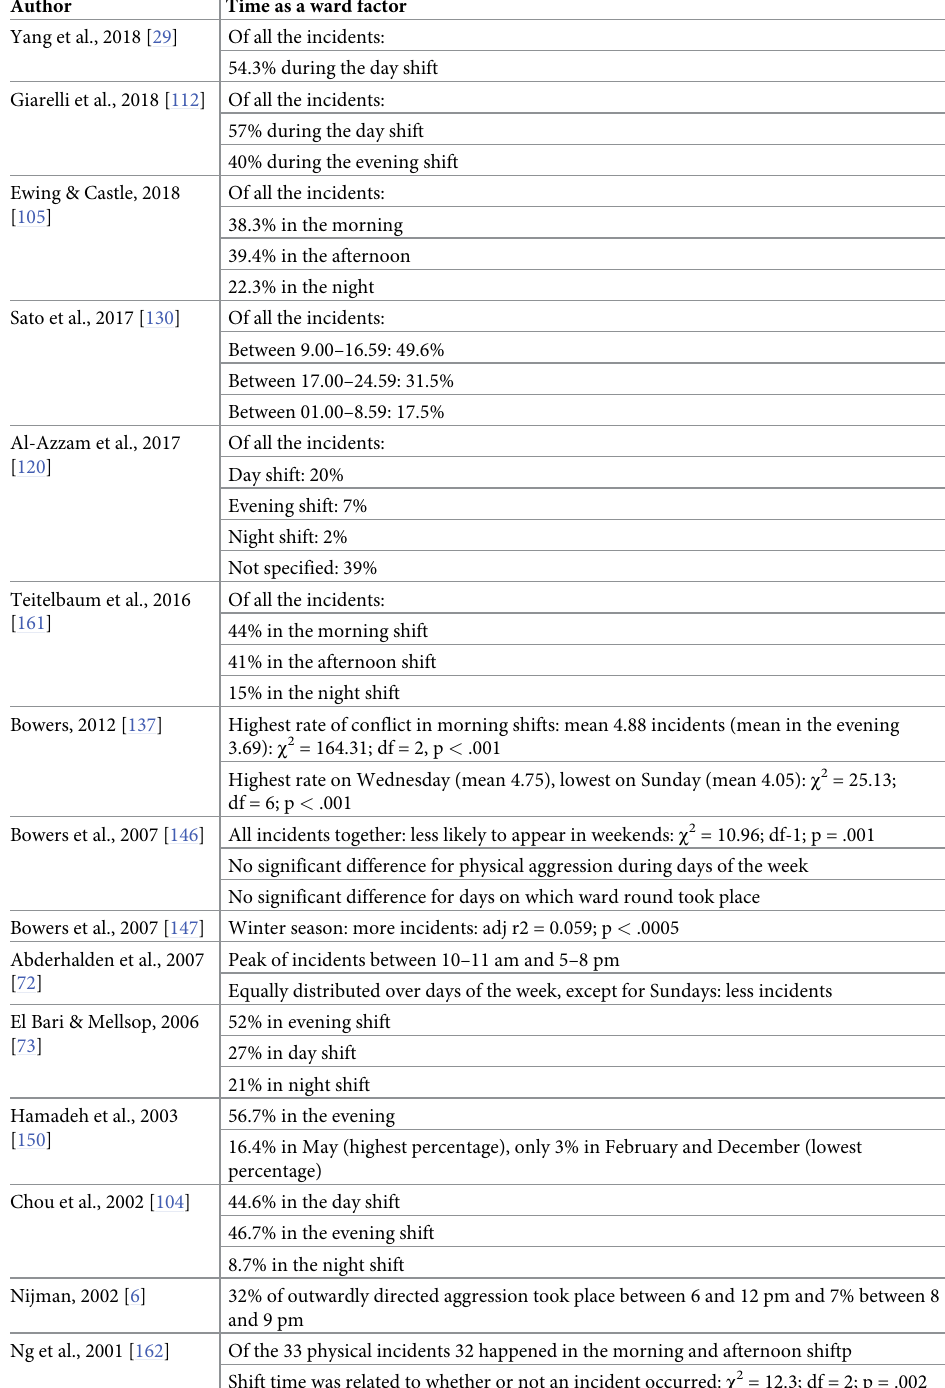
Table 6. Included studies on the potential association of time of day and aggression